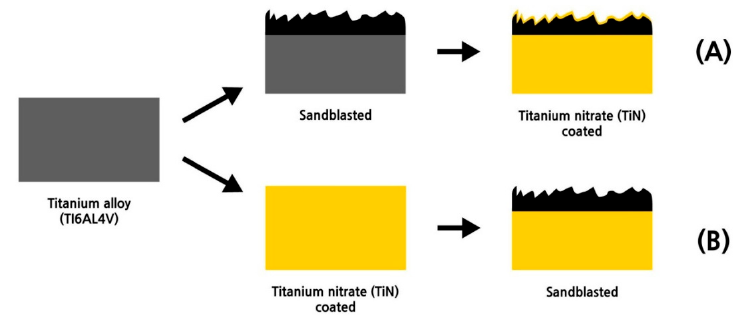
Figure 1. The schematized surface treatment process of Buechel and Pappas knee prosthesis (L-F Knee System, Cellumed Co., Ltd, Seoul, Korea) used in this study. The undersurface treatment process of the prosthesis was changed from ( A ) to ( B ) in late 2013.